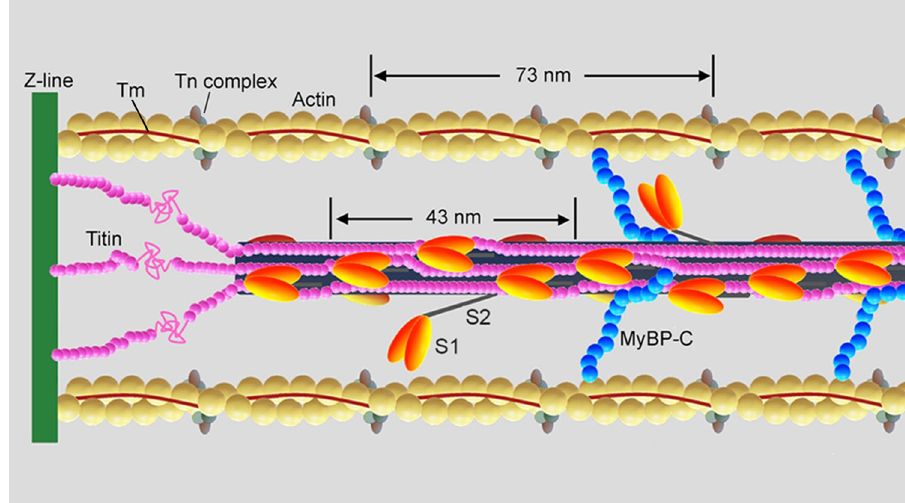
Fig. 1 Schematic representation of the half-sarcomere protein assembly. Shown are actin (yellow), tropomyosin (Tm, brown) and troponin complex (Tn, light and dark grey and violet) on the thin fi lament. On the thick fi lament (black) most of the S1 globular head domains of myosin (orange) lie tilted back (OFF state) and a few heads (two in the scheme) move away with tilting of their S2 tail domain (ON state); the MyBP-C (blue) lies on the thick fi lament with the C-terminus and extends to thin fi lament with the N-terminus. Titin (pink) in the I-band connects the Z line at the end of the sarcomere (green) to the tip of the thick fi lament and in the A-band runs on the surface of the thick fi lament up to the M-line at the centre of the sarcomere. Adapted from Fig. 1 in ref. 78 (permission from Springer